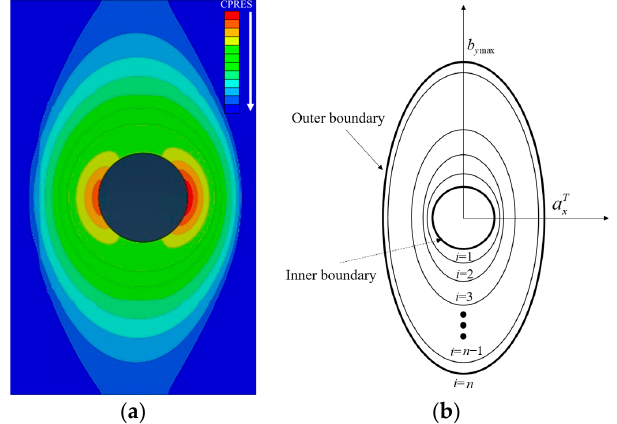
Figure 22. Ellipse modification in microslip.